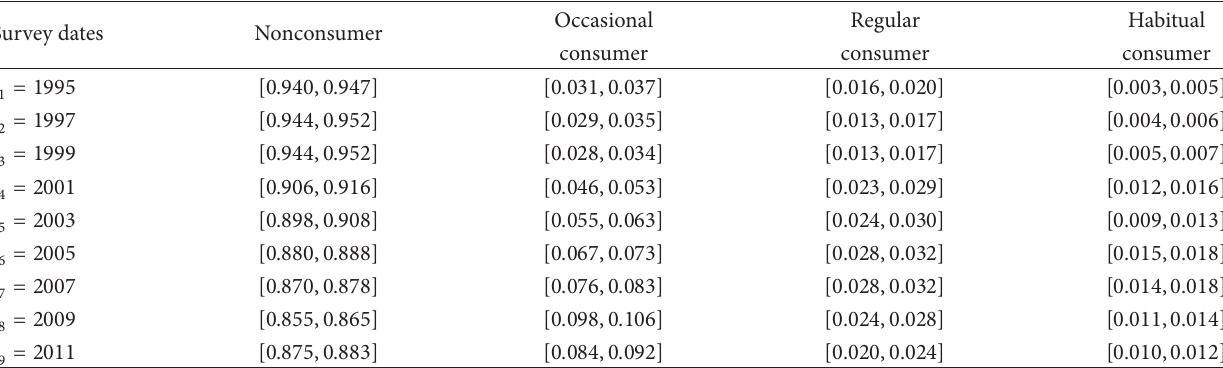
Table 3: 95% CI of the EDADES surveys data using the joint multinomial probability function of each survey. Survey dates